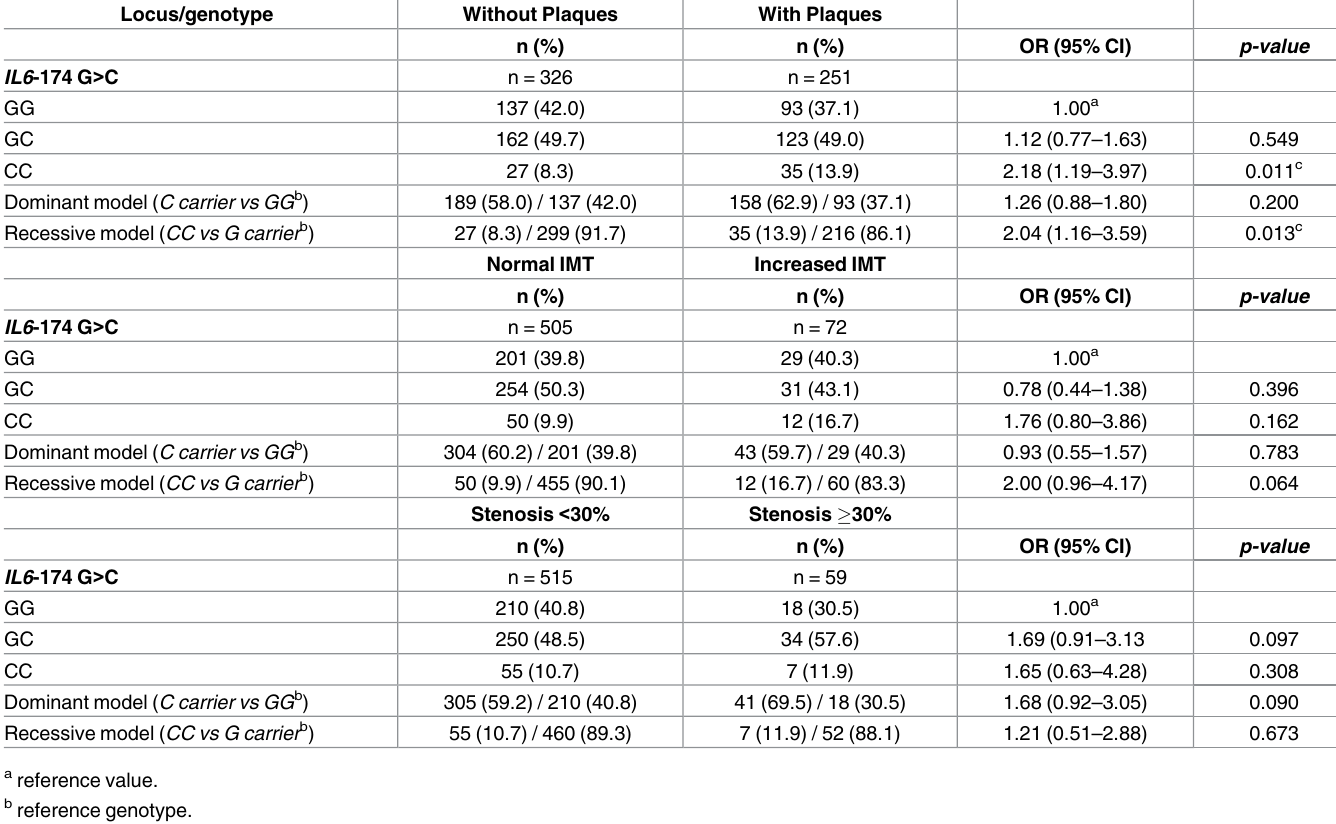
Table 3. Genotypic frequencies and association of the IL6 -174 SNP with presenceof plaques, increased IMT, and degree of stenosis (adjusted for gender, age, hypertension, diabetes, and smoking habits).